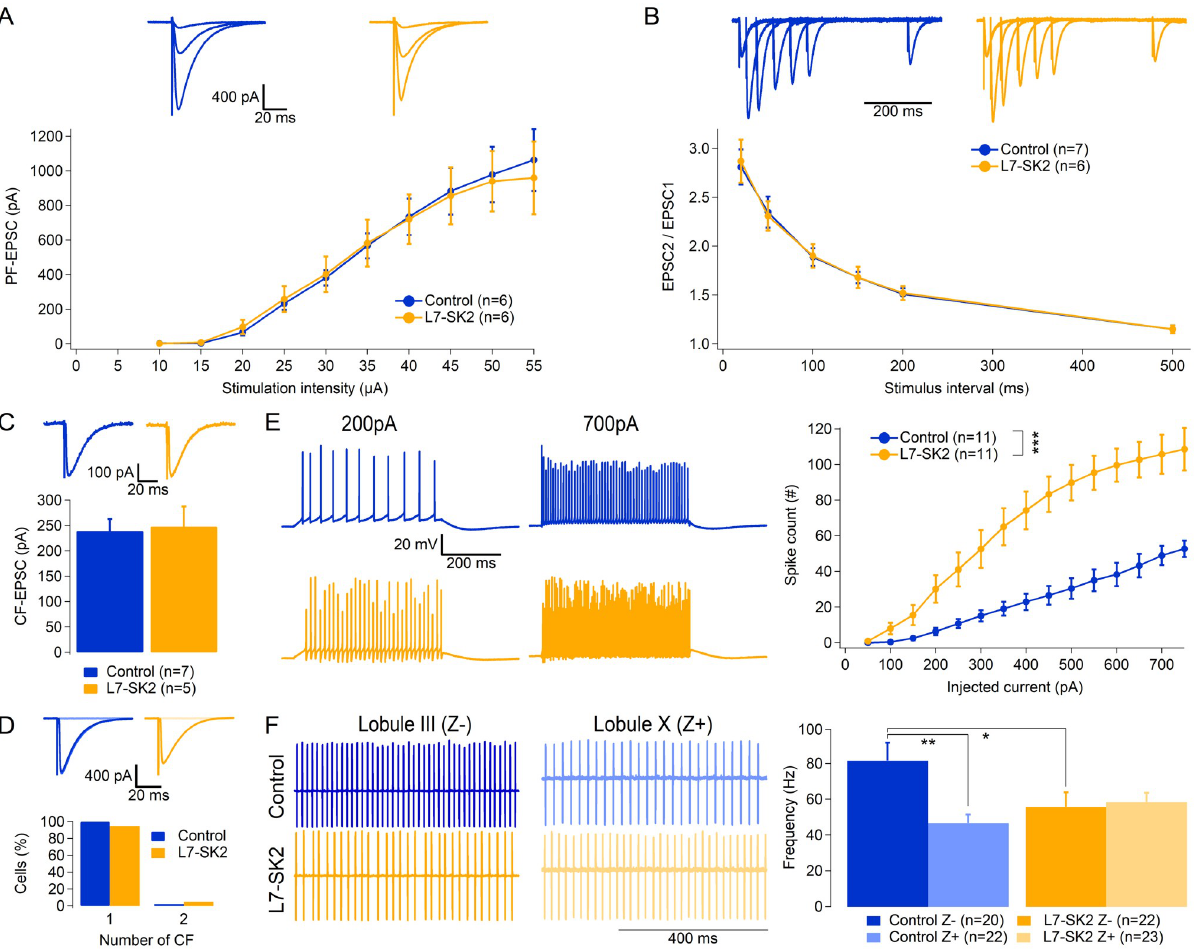
Fig 2. Intrinsic excitability is increased in L7-SK2 mice. (A) PF strength was comparable in L7-SK2 and control mice, as assessed recording PF-EPSCs with increasing stimulation intensities, showing no significant differences (upper panel: representative traces, lower panel: PF-EPSC averaged per group at different stimulation intensities). (B) PF-EPSC PPR was comparable in L7-SK2 and control mice. It was calculated at increasing interpulse intervals as the ratio of the second EPSC over the first one, as a proxy of synaptic release probability (upper panel: representative traces, rescaled for each individual EPSC1; lower panel: PF-EPSCs averaged per group at different stimulation intensities). (C) CF-EPSCs were comparable in L7-SK2 and control mice (upper panel: representative traces, Vm = 0 mV; lower panel: CF-EPSCs averaged per group). (D) The number of CF inputs was comparable in both groups with a virtual absence of multi-innervation (upper panel: representative traces, Vm = − 20 mV; lower panel: distribution of the number of CF inputs). (E) Purkinje cell excitability was increased in L7-SK2 mice, as assessed by the number of spikes evoked by a somatic depolarizing current injection of increasing amplitude (left panel: representative traces at 200 and 700 pA, right panel: spike count averaged per group per current amplitude). (F) Spontaneous simple spike firing rates in zebrin-negative (Z − ; lobule III) and zebrin-positive (Z+; lobule X) Purkinje cells. � p < 0.05; �� p < 0.01; ��� p < 0.001. CF, climbing fiber; EPSC, excitatory postsynaptic current; PF, parallel fiber; PPR, pair-pulse ratio. stimulation intensity × genotype interaction: F[9, 81] = 0.26, p = 0.98, n = 6 cells per genotype), indicating similarly functional connectivity. The paired-pulse ratio (EPSC2/EPSC1) measured at interstimulus intervals ranging from 20–500 ms was also comparable between the two groups, suggesting that the Purkinje-cell–specific mutation does not affect presynaptic release properties at PF to Purkinje cell synapses (Fig 2B; genotype effect: F[1, 10] = 0.077, p = 0.79; interval × genotype interaction: F[5, 50] = 0.21, p = 0.96; n = 7 and 6, respectively, for control and L7-SK2). We then tested synaptic transmission at CF to Purkinje cell synapses, which con- vey error signals and are crucial for PF-LTD induction. CF-EPSC amplitudes were comparable between control (239.2 ± 24.0 pA; n = 7) and L7-SK2 Purkinje cells (248.2 ± 39.6 pA; n = 5;